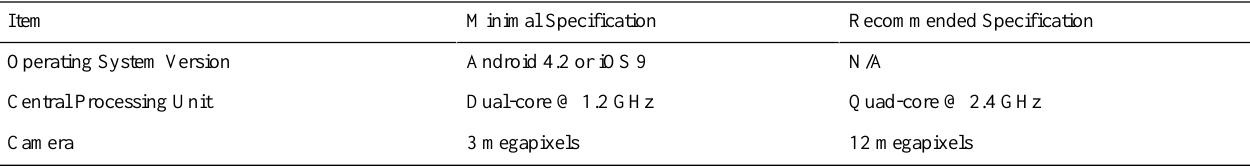
Table 1. Minimal and optional hardware specifications.